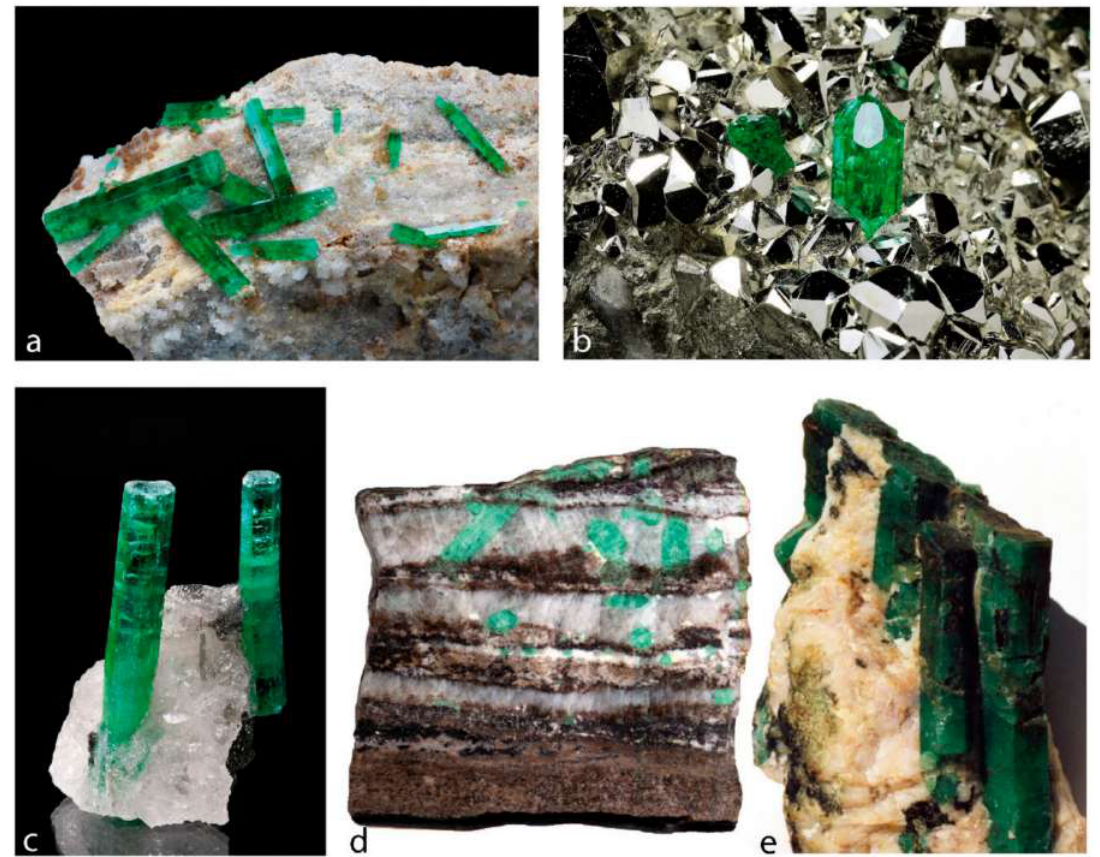
Figure 1. Emeralds’ worldwide photographs: ( a ) Emerald crystals on quartz and adularia, Panjshir Valley, Afghanistan, 6.6 × 4.4 cm. Specimen: Fine Art Mineral. Photograph: Louis-Dominique Bayle, le R è gne Min é ral; ( b ) emerald on pyrite, Chivor, Colombia, 3.9 × 2.6 cm. Collection MulitAxes. Photograph: Louis-Dominique Bayle, le R è gne Min é ral; ( c ) Emerald in quartz, Kagem mine, Zambia, longest crystal: 7.9 × 1.2 × 1.2 cm. The Collector’s Edge. Photograph: Louis-Dominique Bayle, le R è gne Min é ral; ( d ) emerald in quartz vein and minor potassic feldspar, Dyakou, China, longest crystal: 1.5 cm. Specimen DYKO6-zh. Photograph: Dan Marshall; ( e ) emerald in plagioclase, Carna í ba, Brazil, longest crystal: 6 cm. Photograph: Gaston